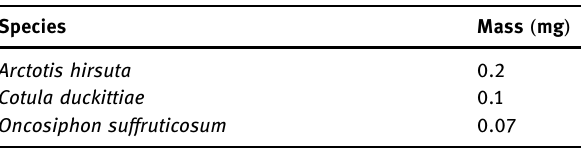
Table 1: The determined mass of achenes for the three winter - rainfall annuals at KNBG